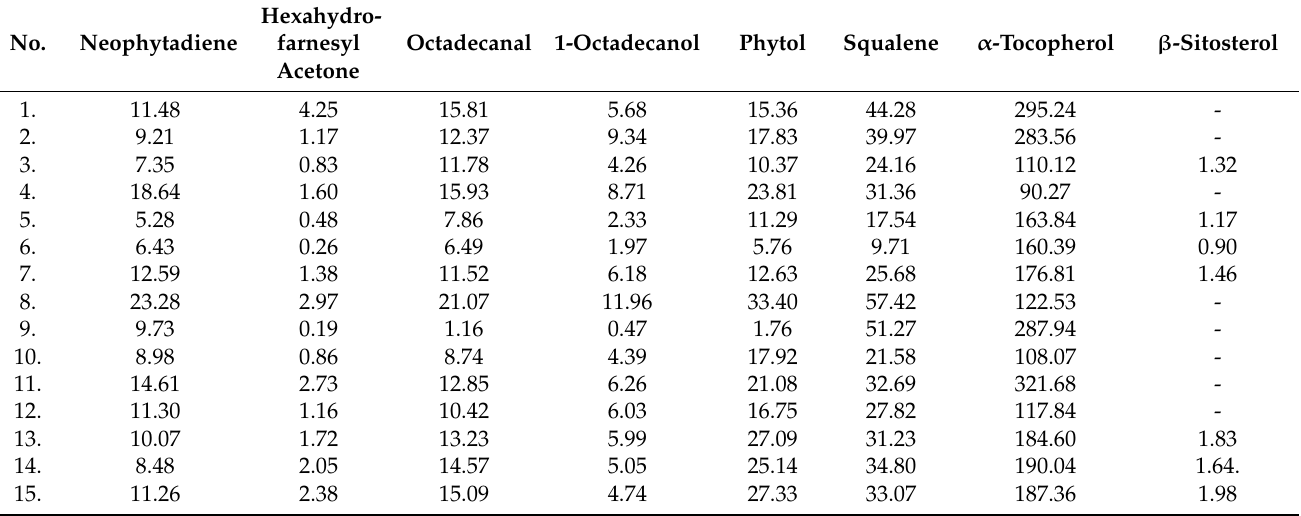
Table 3. The relative amount (in mg α -tocopherol equivalents per 100 g of dry leaves) of the phytochemicals in the SC CO 2 extracts of P. persica amber leaves.